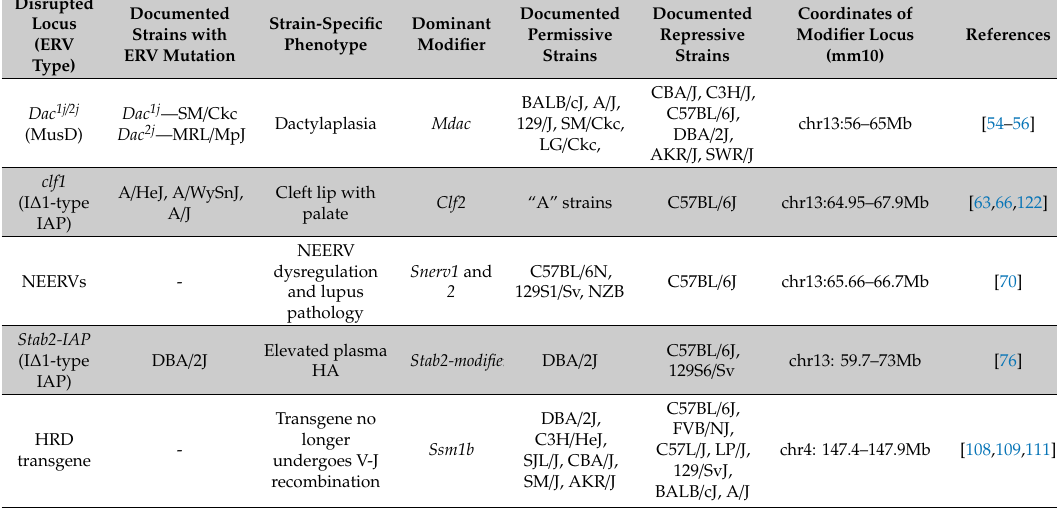
Table 1. Overview of mapped strain-specific